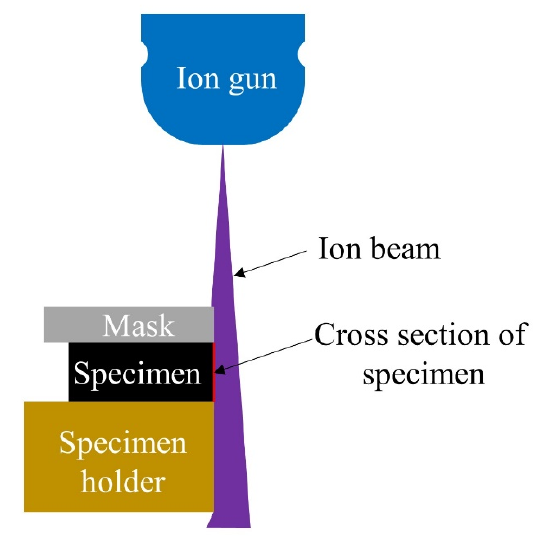
Figure 2. Diagram of cross section polishing by ion milling system.